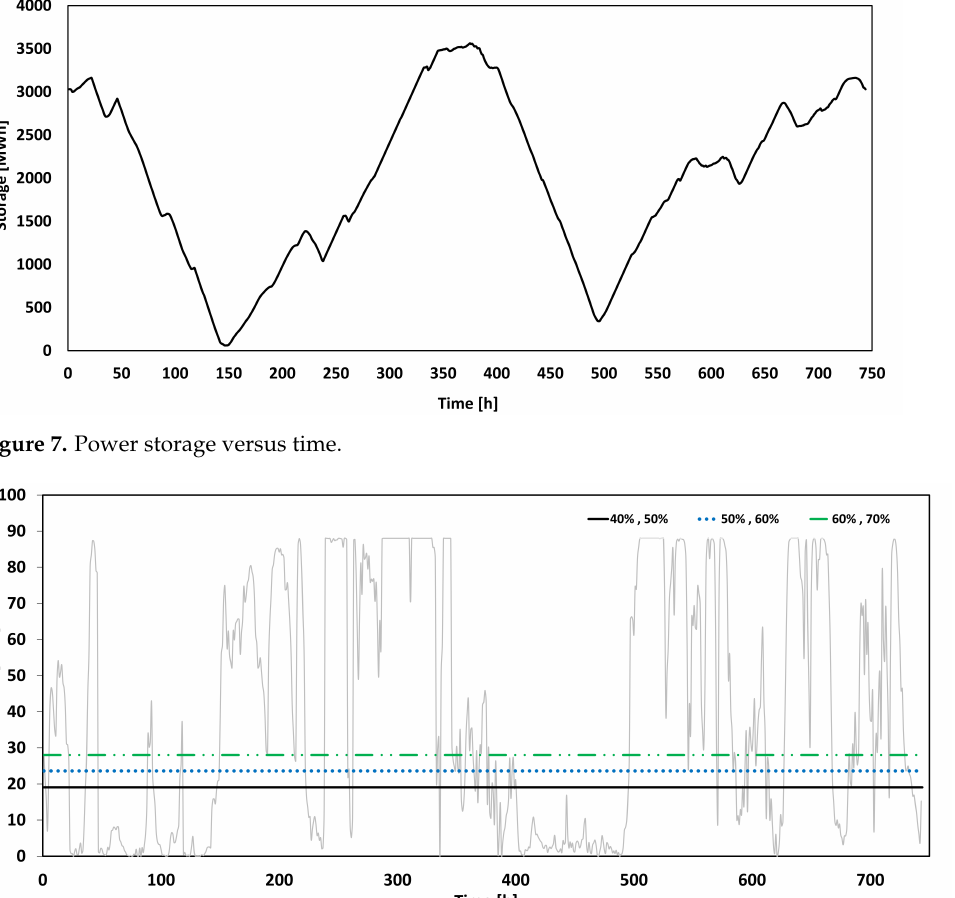
Figure 8. Constant power supply from wind power for different